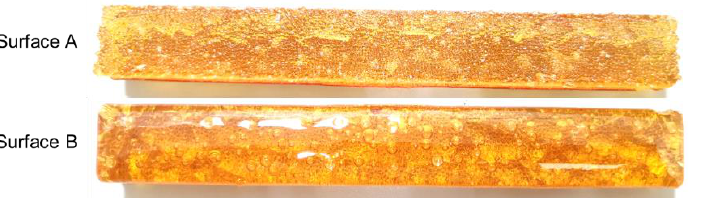
Figure 2. Bubbles in resin with a high proportion of phenolic (Surfaces A and B are indicated in Figure 1).